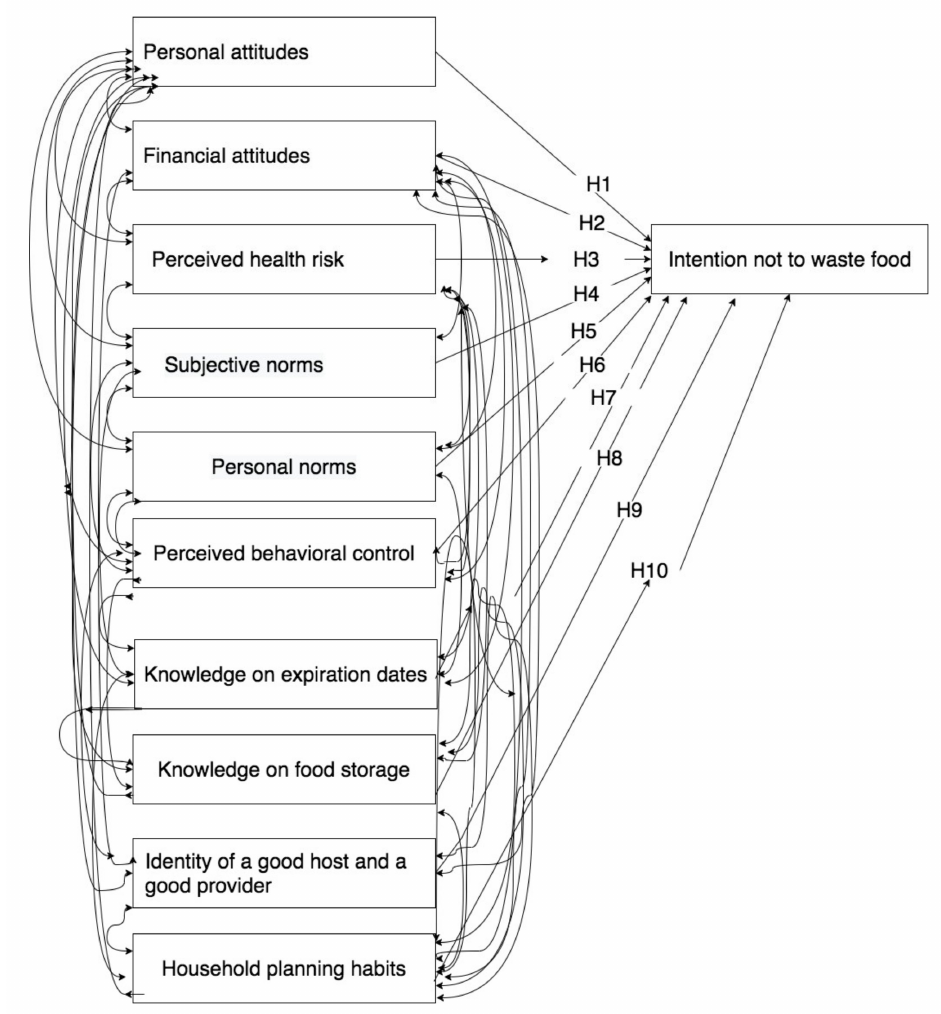
Figure 1. Hypotheses and the extended Theory of Planned Behavior (TPB)